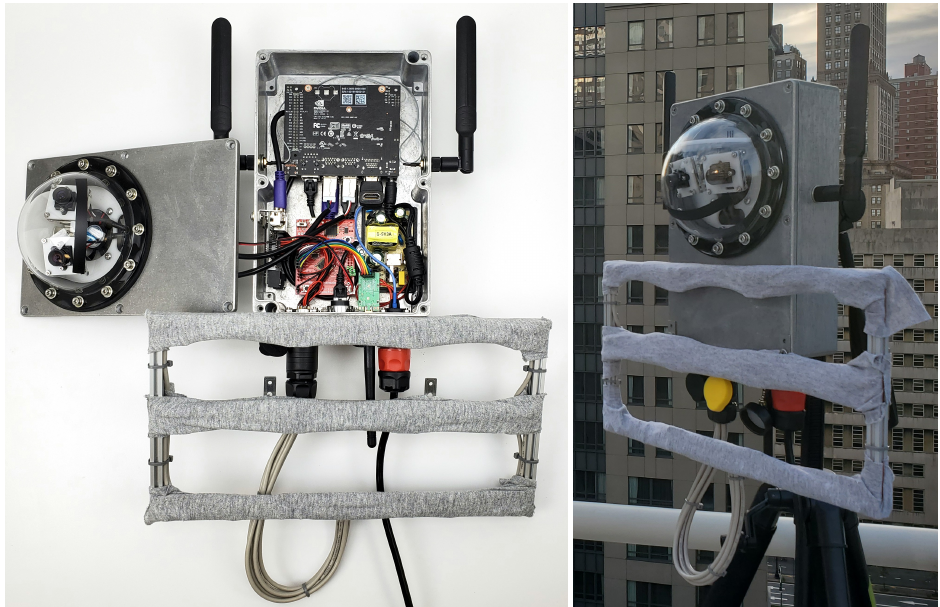
Figure 6. Multimodal sensor built for the real-world case study. It includes two 5 MP cameras, a 12 channel microphone array (4 × 3) and a cellular modem. The sensor is waterproof for outdoor operation and powered by the NVIDIA Jetson Nano, which is thermally coupled to the aluminum enclosure for passive/silent